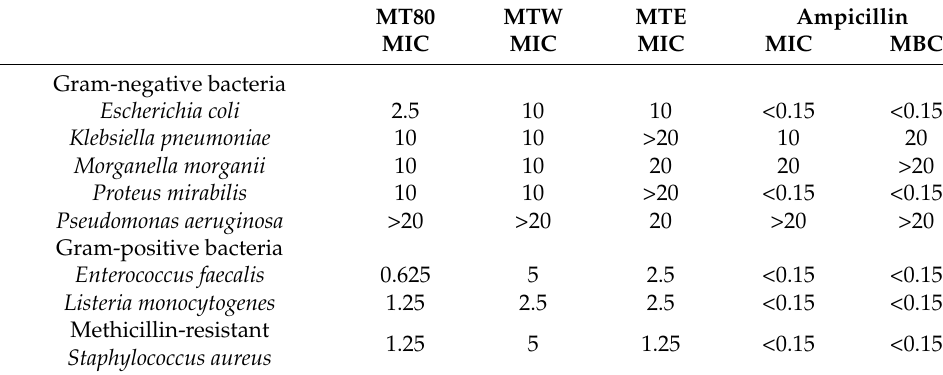
Table 4. Antibacterial potential of the mangosteen pericarp